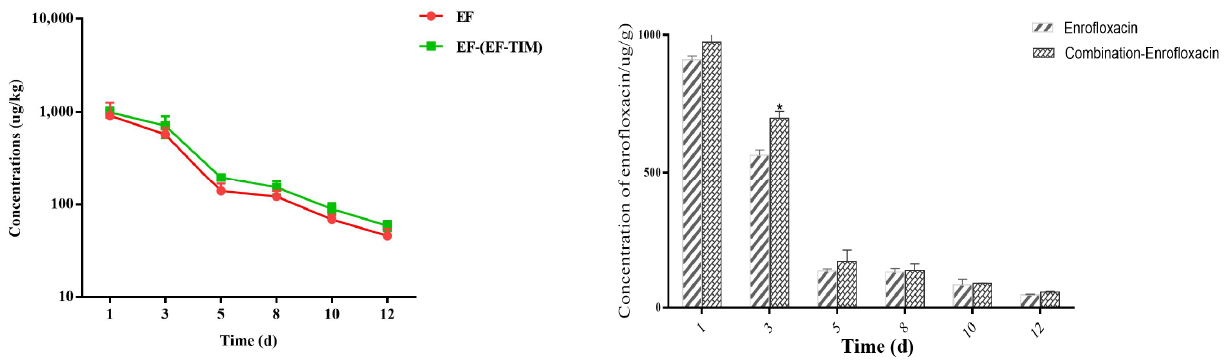
Figure 2. Time-lapse graphs of EF in eggs. Note: EF (enrofloxacin), TIM (tilmicosin). The data were expressed as mean ± SD. * p < 0.05 denoted statistical significance.